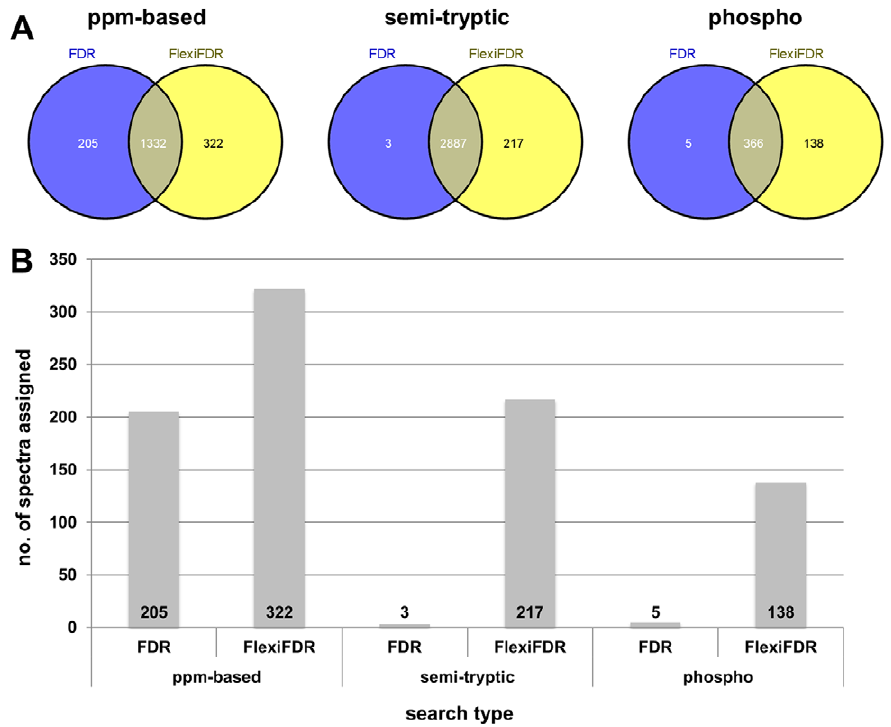
Figure 5. ppm, semi-tryptic and modification searches. This figure denotes versatility of FlexiFDR on ppm based (plasma data), semi tryptic (QTOF) and Phosphorylation modification searches (Phospho data). Details for searches are given in methods. These different searches depict improved performance after applying FlexiFDR. Panel A shows direct Venn comparisons for the three searches. Their corresponding unique spectra are compared in bar graphs below them in panel B to show the